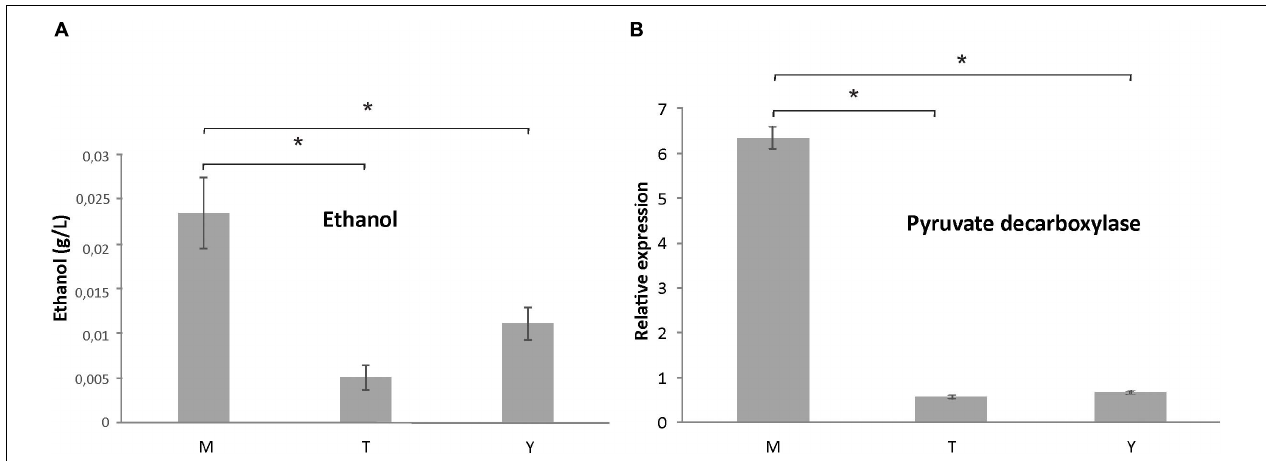
FIGURE 2 | Ethanol measurements in protein extracts of mycelium, mycelium-to-yeast transition, and yeast cells, and analysis of the transcript encoding pyruvate decarboxylase by qRT-PCR. (A) Measurement of ethanol accumulation in P. brasiliensis morphological phases: M, mycelium; T, transition mycelium-to-yeast cells; Y,